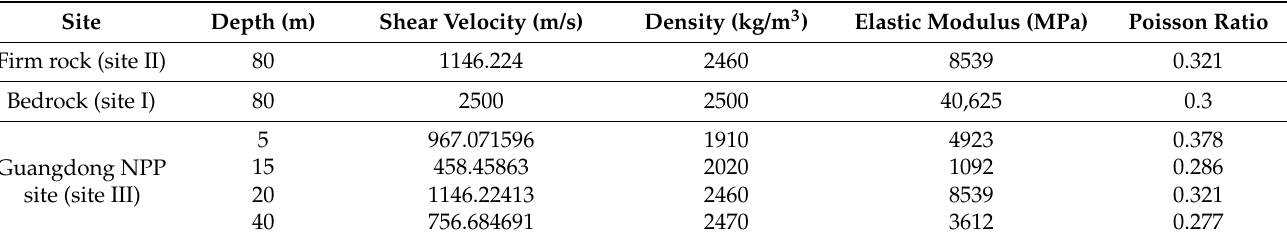
Table 1. Sites geotechnical parameters.